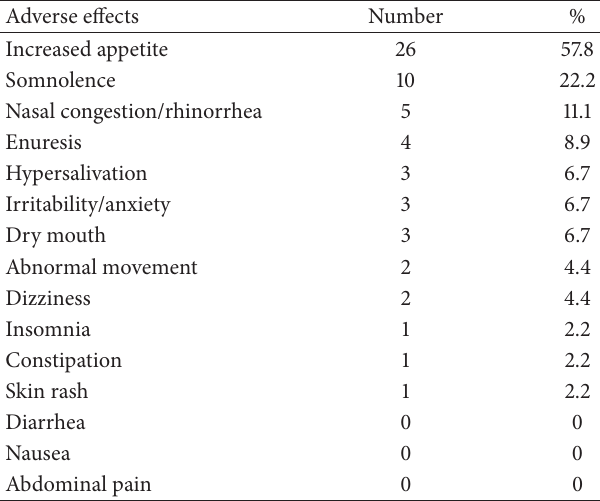
Table 2: Reported adverse effects of